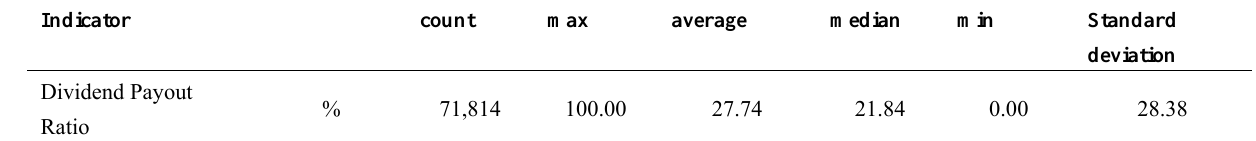
Table A.2.1 : Descriptive